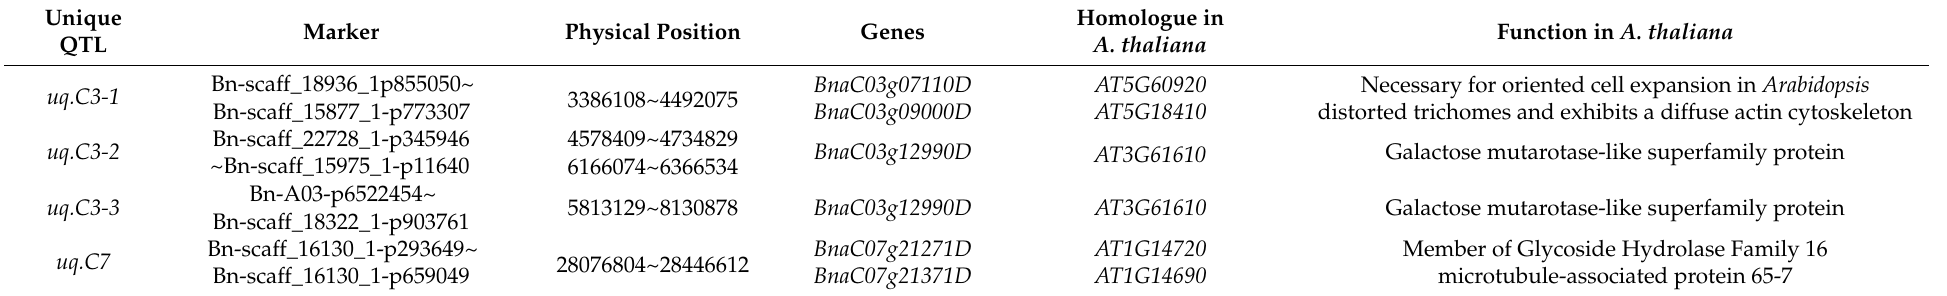
Table 4. Candidate gene information of crude fiber component associated loci in B. napus shoots.